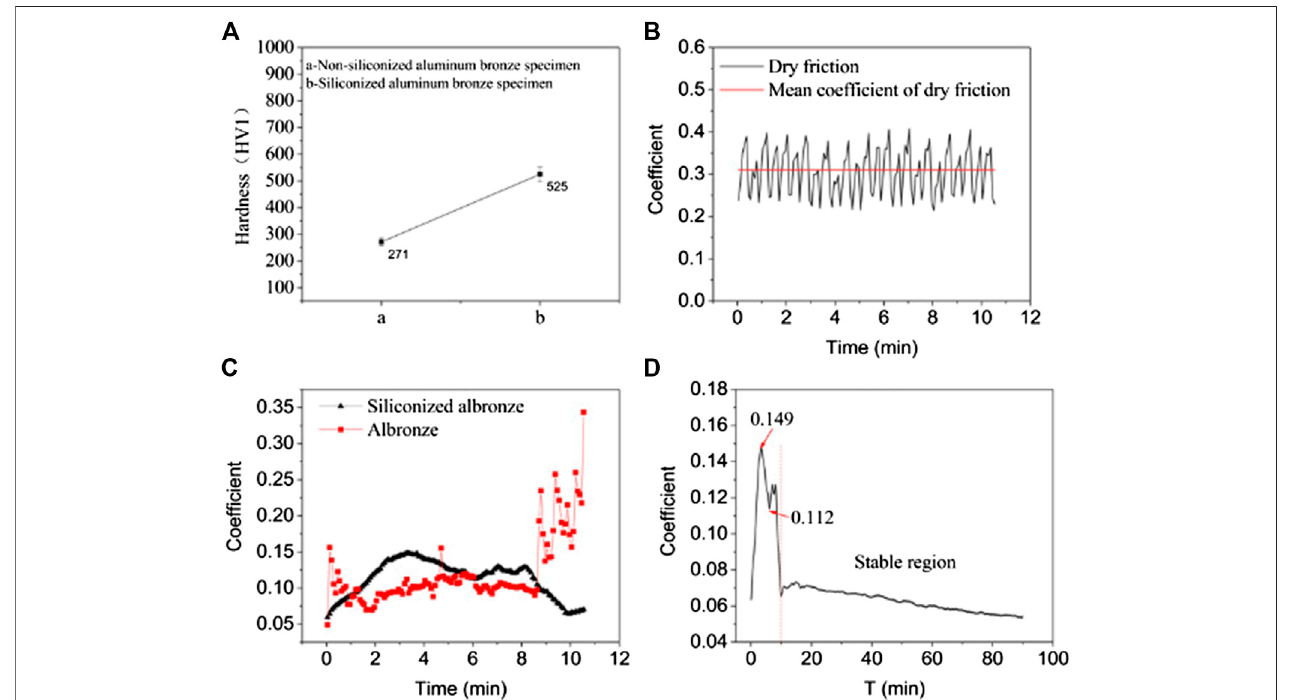
FIGURE4|(A) AVickershardnessofthesiliconizedaluminumbronzeandthenon-siliconizedaluminumbronzesample(30%Sicontent). (B) Thedryfrictiontestof the non-siliconizedsample. (C) TheLubricationfriction ofthesiliconized aluminum bronze and thenon-siliconized aluminum. (D) The lubrication friction coef fi cient ofthe siliconized sample in 90